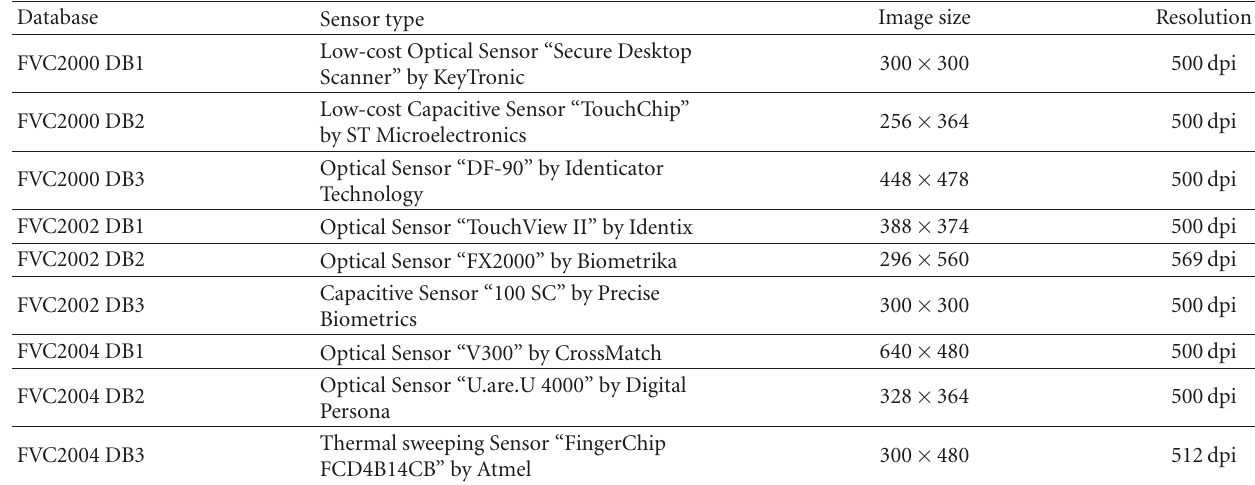
Table 1: FVC fingerprint database sensor list.